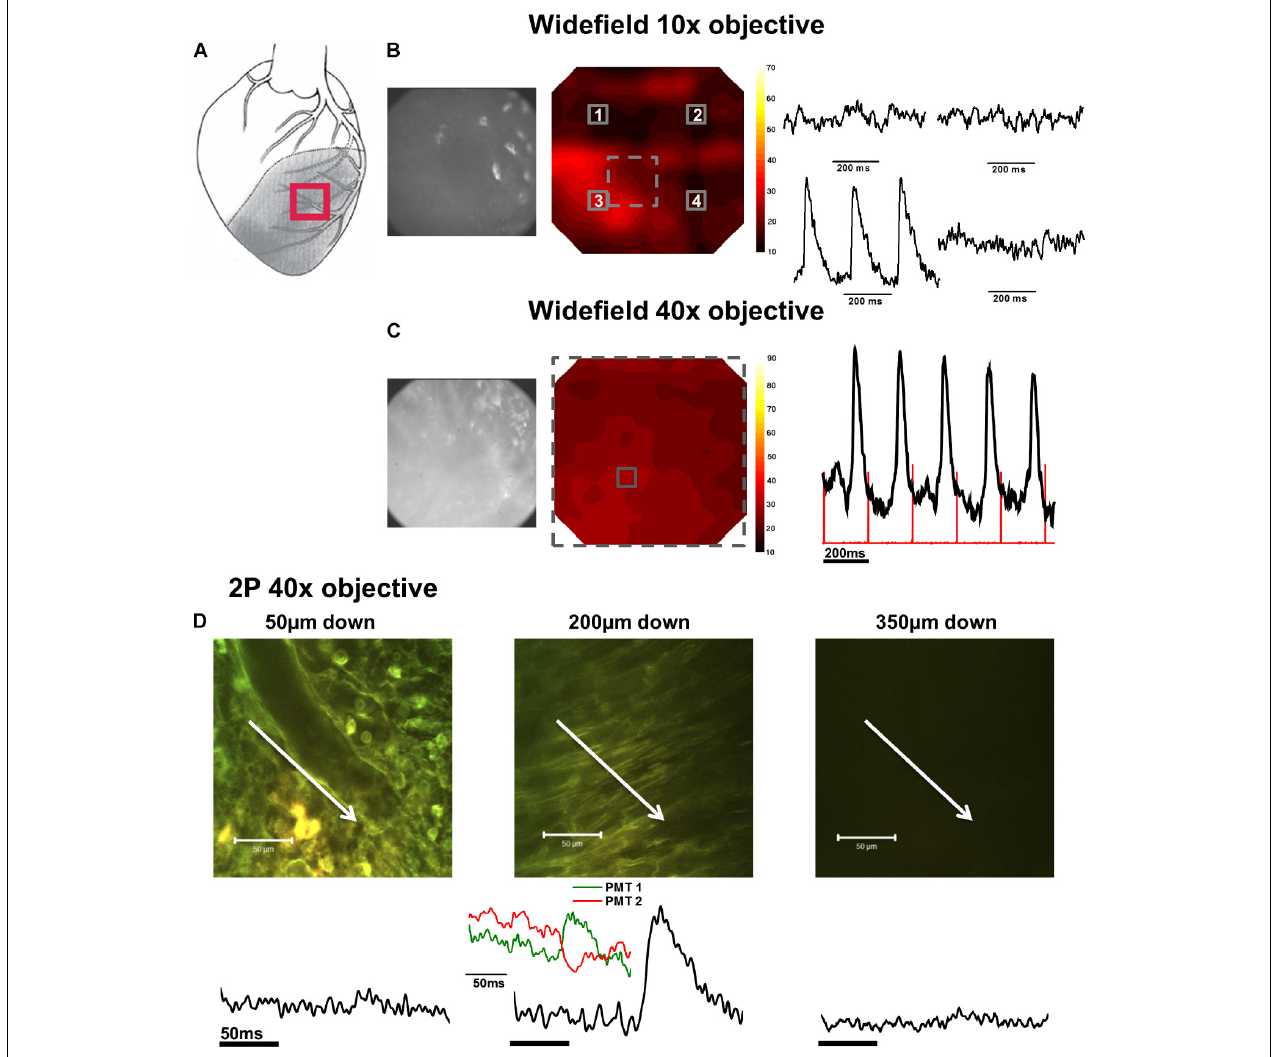
FIGURE 4 | Widefield and 2P signals in the infarct zone (IZ). (A) Schematic diagram of the infarcted heart. Red square indicates the approximate location of the measurements in the IZ. (B) Widefield measurements taken from the IZ using a 10 × objective. From left to right; CMOS camera image of di-4-ANEPPS fluorescence; contour map of di-4-ANEPPS signal-to-noise; 3 × 3 pixel averages (indicated by numbered solid squares in contour map) demonstrated absence of signal in all but one region of the infarct. (C) Measurements were then focused to a smaller area using a 40 × objective [indicated by the dashed square on the contour map in (B) ]. From left to right; CMOS camera image of di-4-ANEPPS fluorescence in the IZ; contour map of signal-to-noise in the 40 × field of view; 3 × 3 pixel average of the AP signal defined by the solid square in the contour map – red lines indicate timing of the stimulus pulse. (D) 2P images and the corresponding voltage signal taken at (from left to right) 50, 200, and 350 µ m below the tissue surface. At 200 µ m below the tissue surface, tissue structure appears more organized and AP waveforms with slow activation times and upstrokes become apparent from the fluorescence ratio. Closer inspection of the individual PMT signals (inset) demonstrate an increase in fluorescence at the shorter waveband and a decrease in the longer waveband, eliminating the possibility of the fluorescence ratio signal being due to movement artefact. White arrows in images indicate approximate length and direction of line scans. All the APs shown are an average of 25 APs recorded over a period of 5